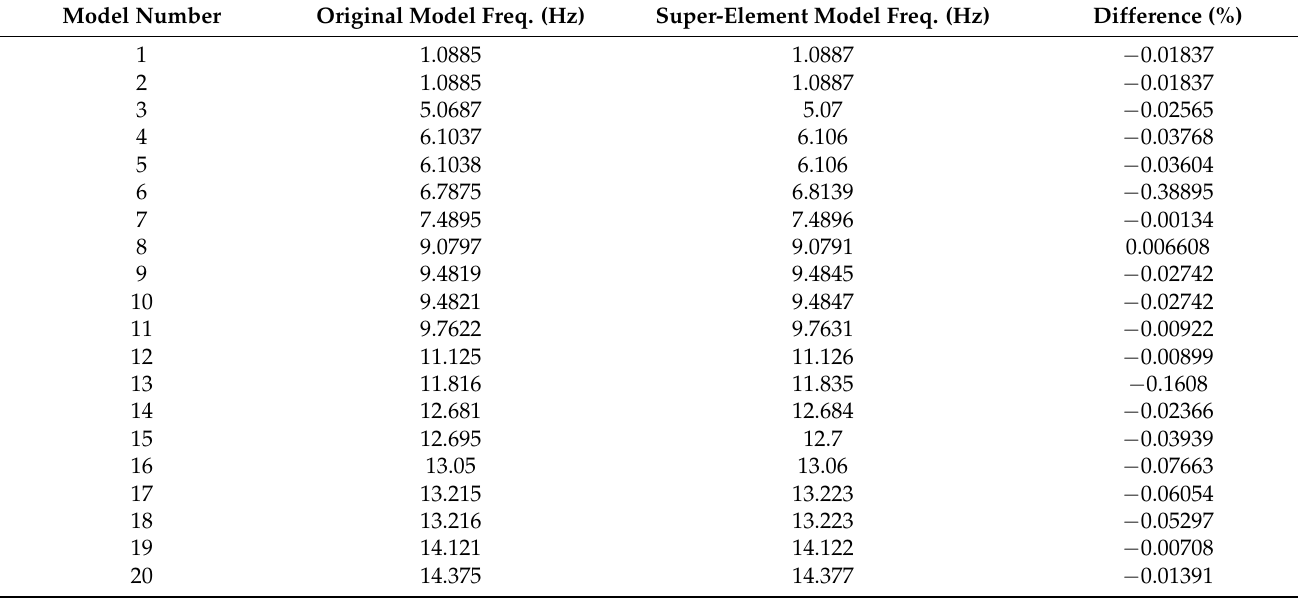
Table 9. Comparison of modal frequencies of the original and super-element models.